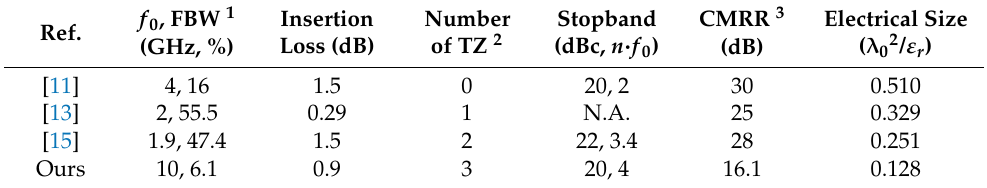
Table 1. Comparison between the proposed balanced filter and some similar reported works.